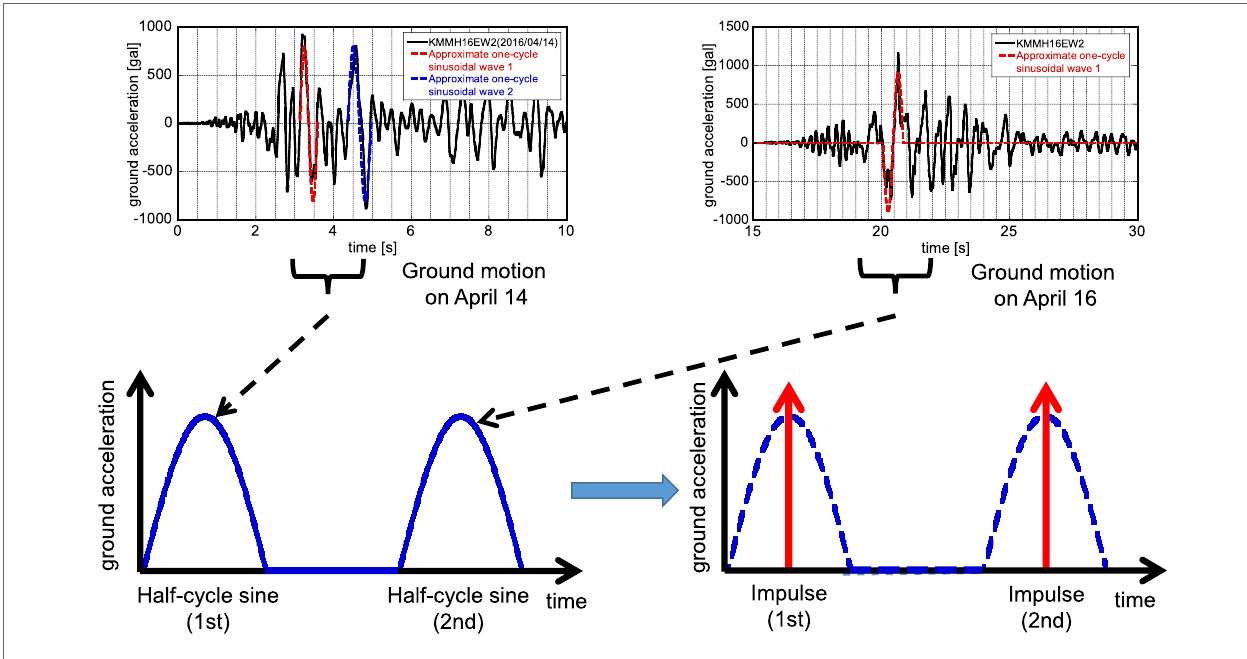
FIGURE 1 | Modeling of repeated intensive ground motions into two impulses .